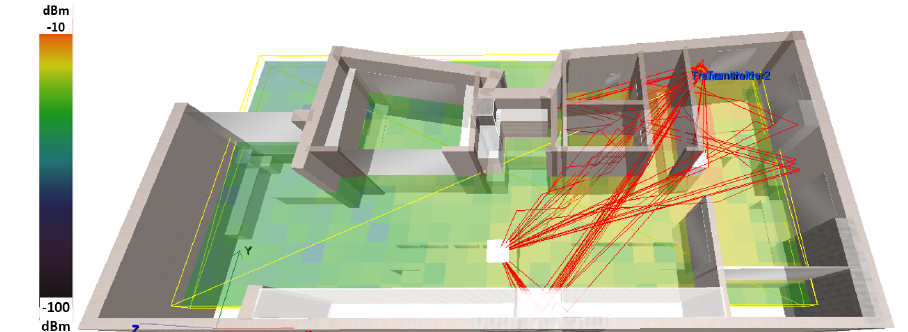
Figure 4. Multipath effect in indoor environment (Rx Cell 198).